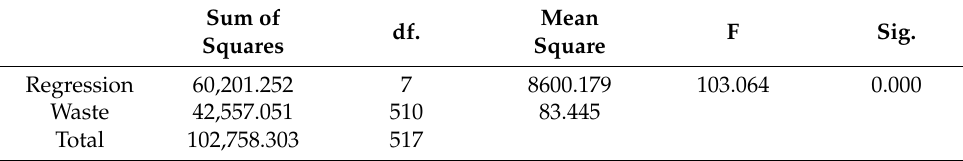
Table 4. ANOVA result for Model 1.